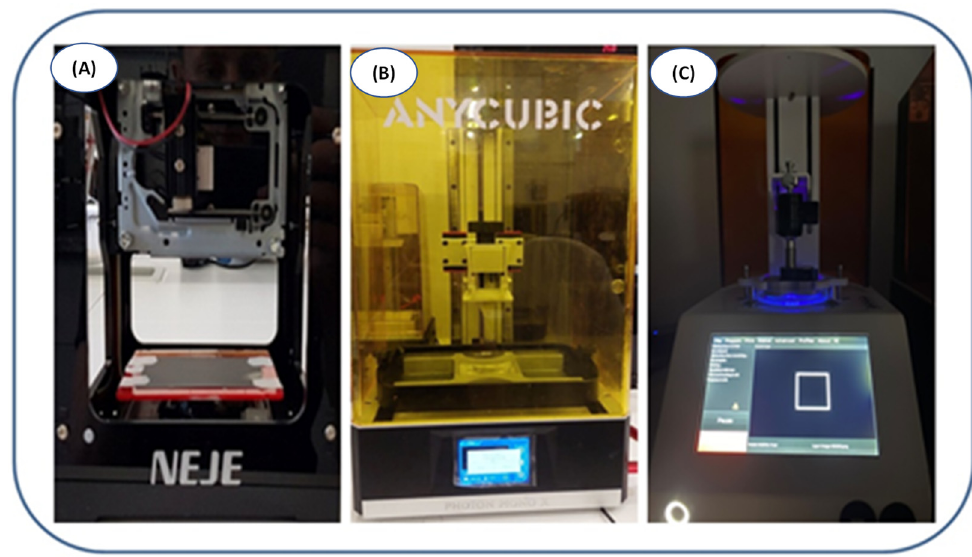
Figure 3. ( A ) NEJE laser engraver printer; ( B ) Photon Mono X printer; ( C ) LumenX printer.